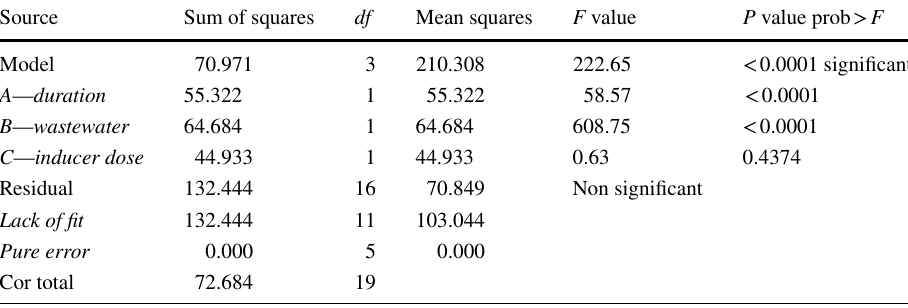
Table 5 ANOVA results for the response surface quadratic model for the MnP